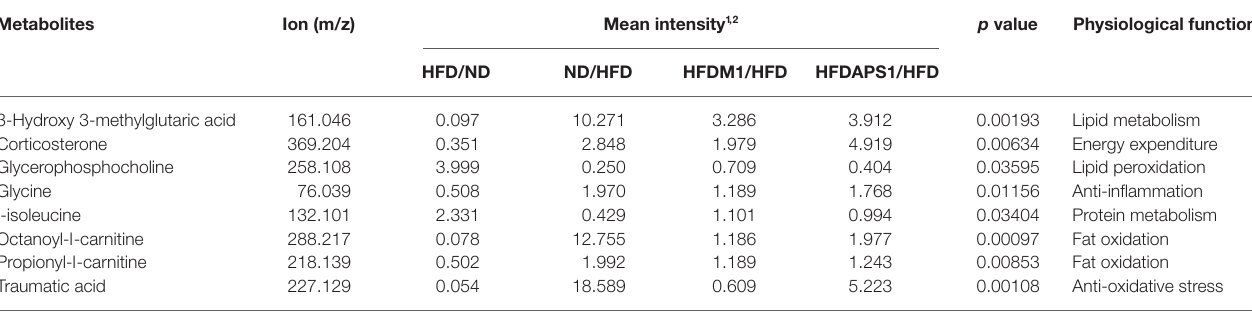
TABLE 1 | The detected [by liquid chromatography–mass spectrometry (LC-MS)] differential metabolites of plasma sample among the normal diet (ND), high-fat diet (HFD), HFDM1, and HFDAPS1 groups. Metabolites